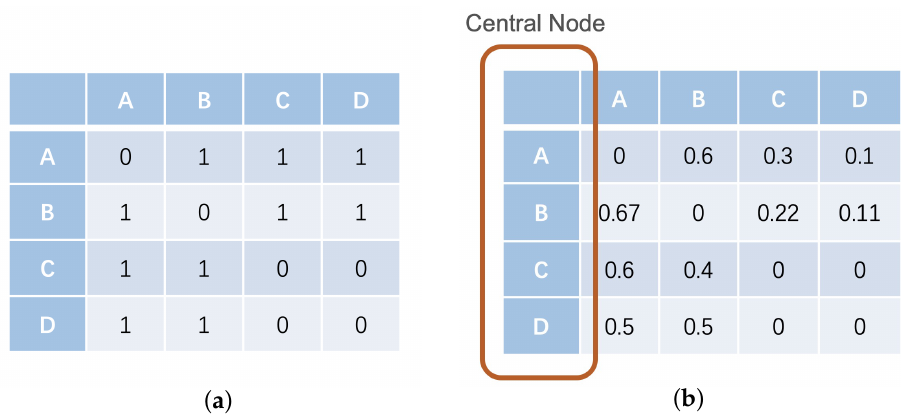
Figure 5. Adjacency feature graph. ( a ) Original binary adjacency graph; ( b ) an asymmetric bidirec- tional edge feature graph of the central